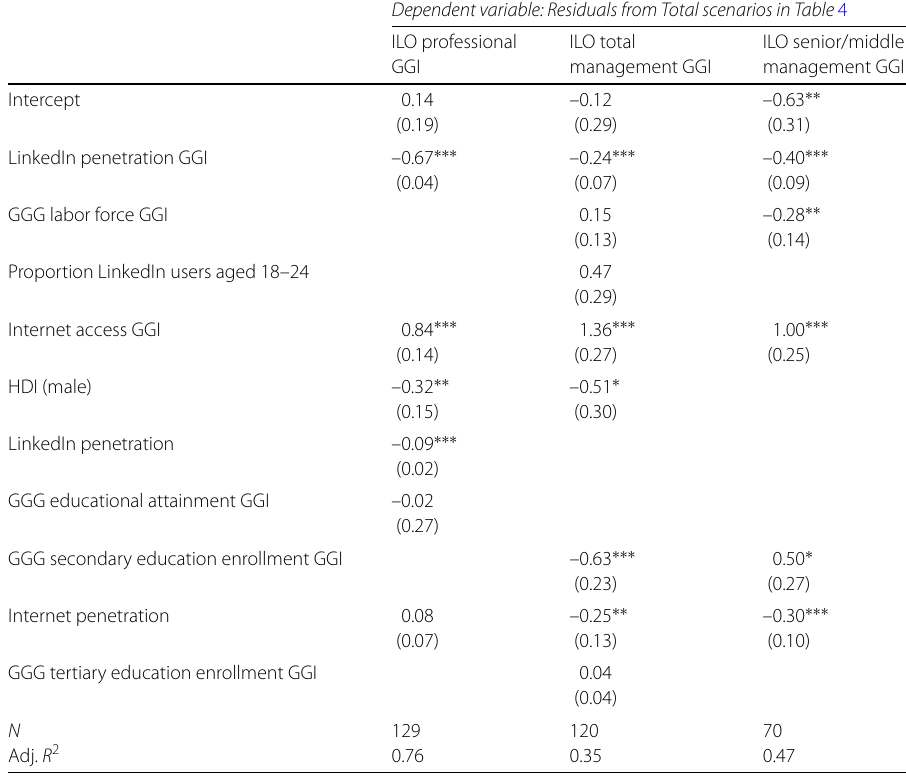
Table 6 Regression coefficients for model predicting the residuals from the total scenario regressions in Table